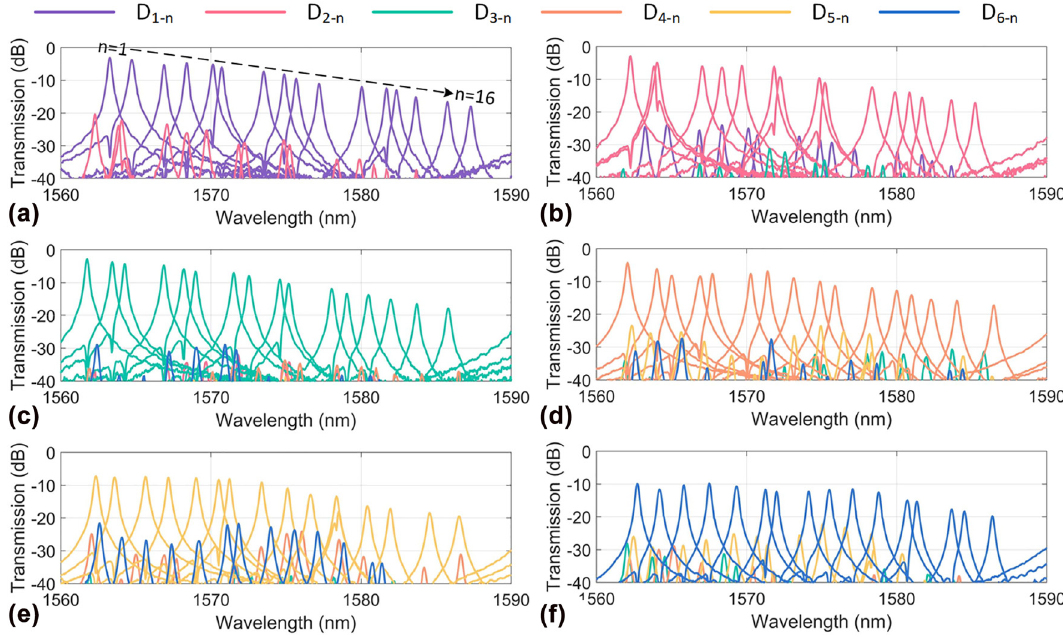
at drop port D ( m = 1, 2, 3, 4, 5, 6) when light is input from port I i − m − n m − n